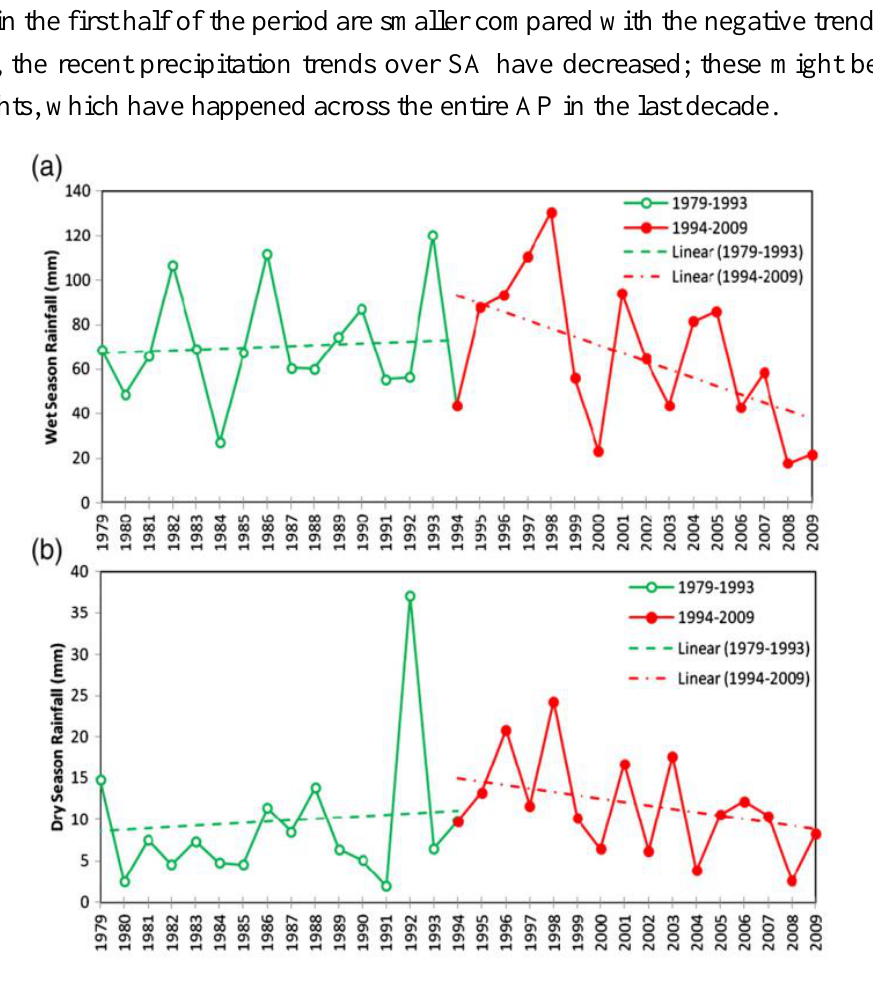
Figure 8. Time sequences of the observed ( a ) wet season and ( b ) dry season rainfall